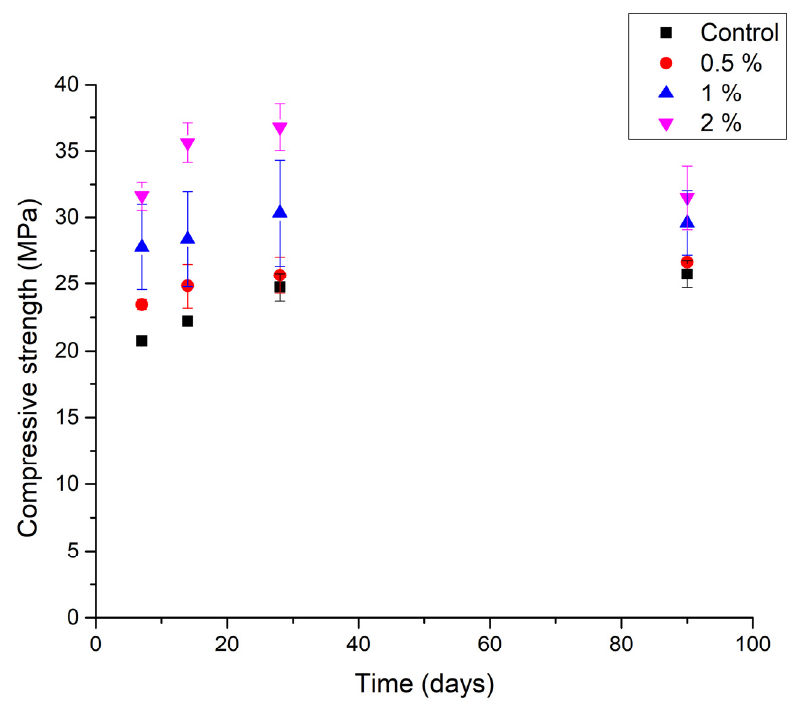
Figure 4. Compressive strength as a function of time and fiber proportion.